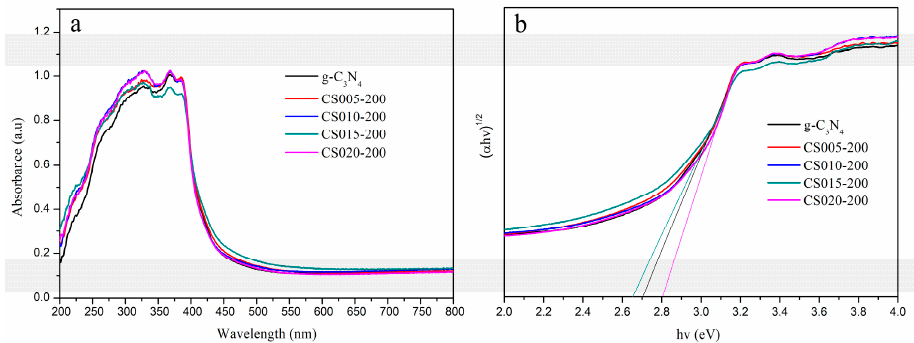
Figure 6. UV–Vis spectra ( a ) and band gap ( b ) of g-C 3 N 4 , CS005-200, CS010-200, CS015-200, CS020- 200.